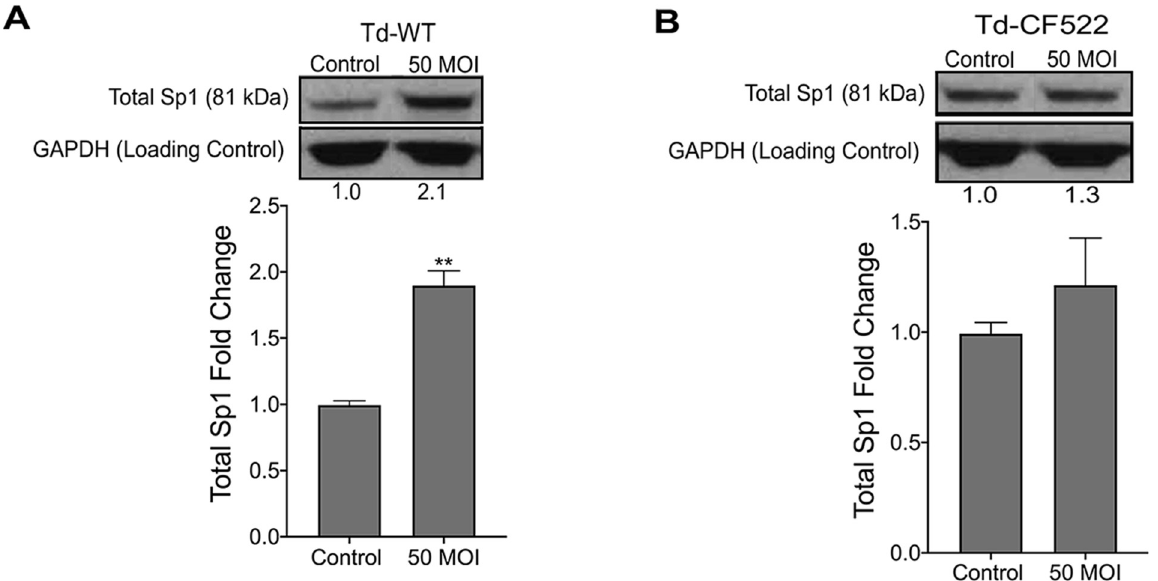
Fig 6. Healthy hPDL cells were challenged with A) Td-WT and B) isogenic Td-CF522 bacteria at an MOI of 50 as previously described. Whole cell lysates were generated and used for Western Blot analysis utilizing total anti-Sp1 antibodies. Total Sp1 protein expression was normalized against GAPDH protein expression as a loading control. Statistical significance was determined using a paired t-test. Bars represent mean ± SD (n = 3). �� p < .01 versus control.